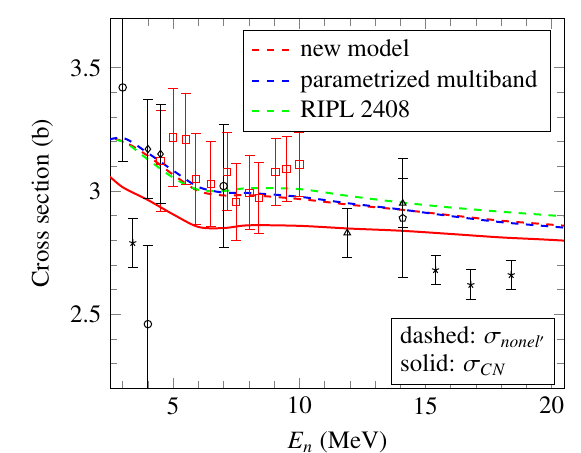
Figure 2. Calculated nonelastic cross sections (dashed) for neu- tron scattering on 238 U using three dispersive optical model po- tentials: RIPL 2408 – rigid-rotor GS band coupling [12–14], multiband coupling with fitted “e ff ective” deformations [17], and current model with SRM-derived multiband coupling. Derived experimental nonelastic neutron scattering cross sections from EXFOR [22–26] (black points) and Dietrich [27] (red points) are compared to calculations. Note that the direct inelastic cross sec- tions of the first two excited levels were also included as quasi- elastic cross sections to derive the plotted non-elastic cross sec- tion σ nonel . Calculated CN formation cross section using the (cid:31) new SRM model is shown as solid line for comparison. timated non-elastic cross sections by Dietrich [27] 2 . An acceptable agreement is seen between calculated (dashed lines) and experimental cross sections (black and